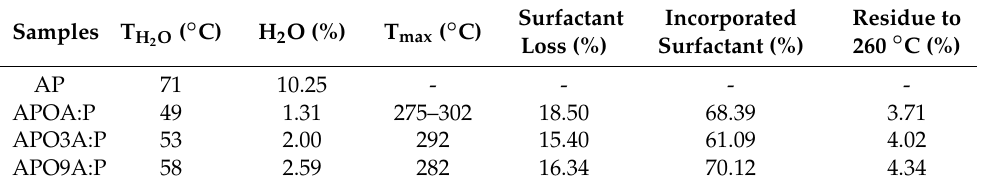
—volatilization temperature of the water; H 2 O—percentage of water loss; Tmax—maximum decomposition temperature of the surfactant.